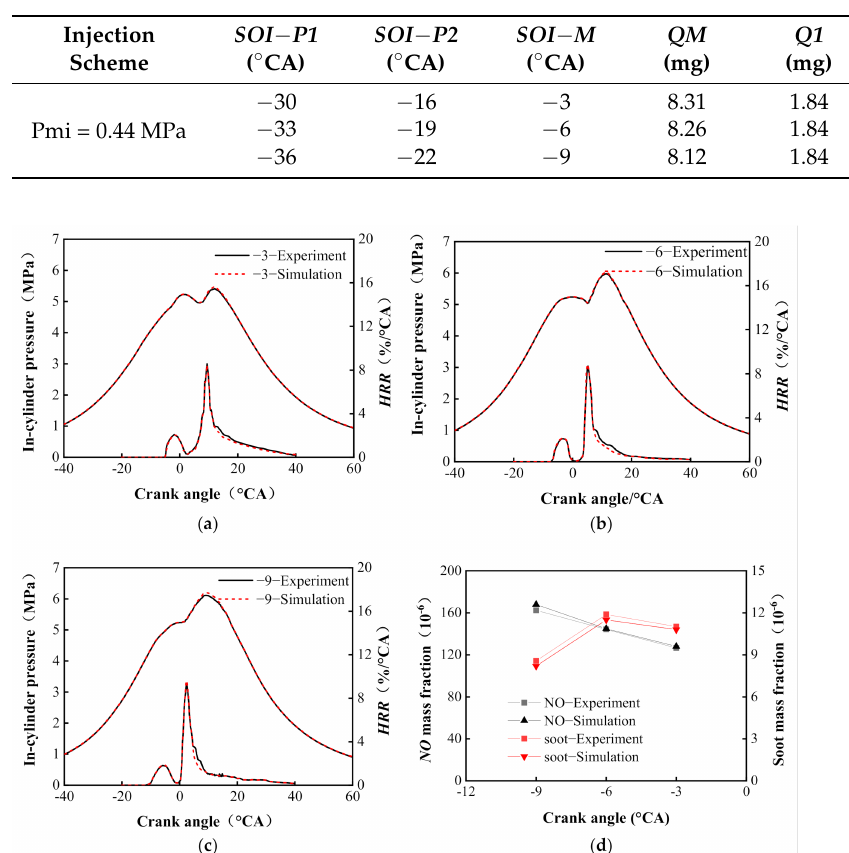
Table 6. Injection parameters for a real operation mode.